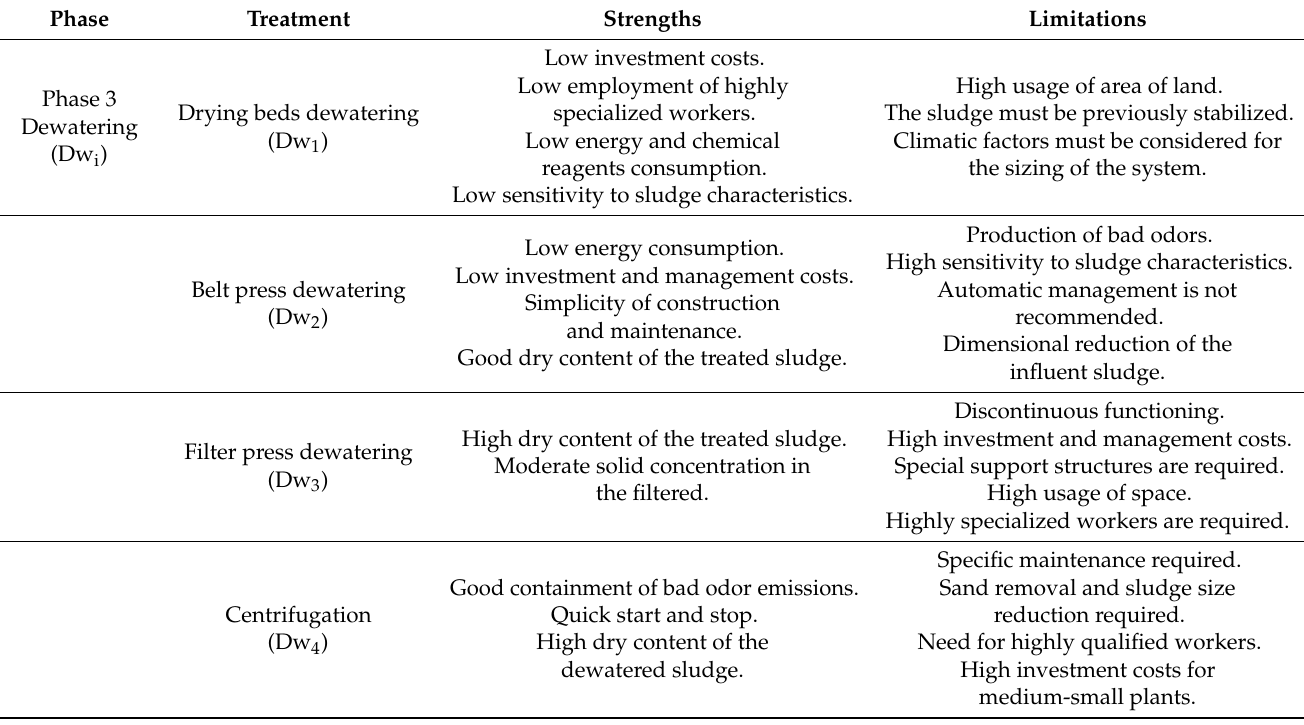
Table 4. Strengths and limitations of all considered alternatives to carry out the dewatering treatments of the modeled SSTS. Phase Treatment